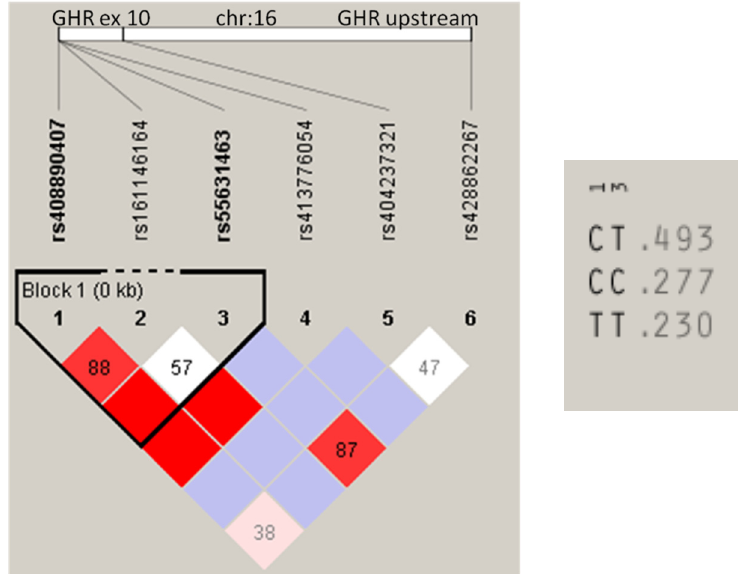
Figure 1. LD block defined by the SNPs genotyped in Sarda sheep ( n = 1112), shown with haplotype frequencies on the right. LD plot of the SNPs on chromosome 16, including the GHR gene. Haploview plot of pairwise D ′ : red, D ′ = 1.0 and logarithm of the odds (LOD) ≥ 2.0; white, D ′ < 1.0 and LOD < 2.0. LD blocks are delimited by a black line. Haplotype-tagging SNPs are within black boxes. SNPs in bold are haplotype-tagging SNPs (htSNP).